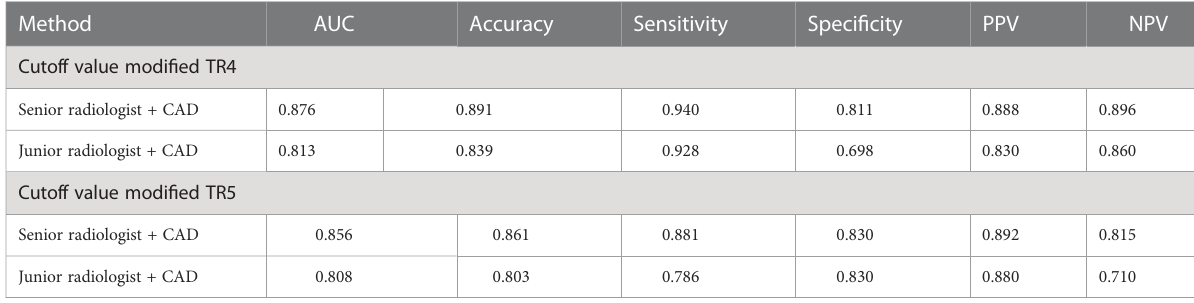
TABLE 5 Quantitative indicators of the two radiologists with different seniority assisted by the CAD